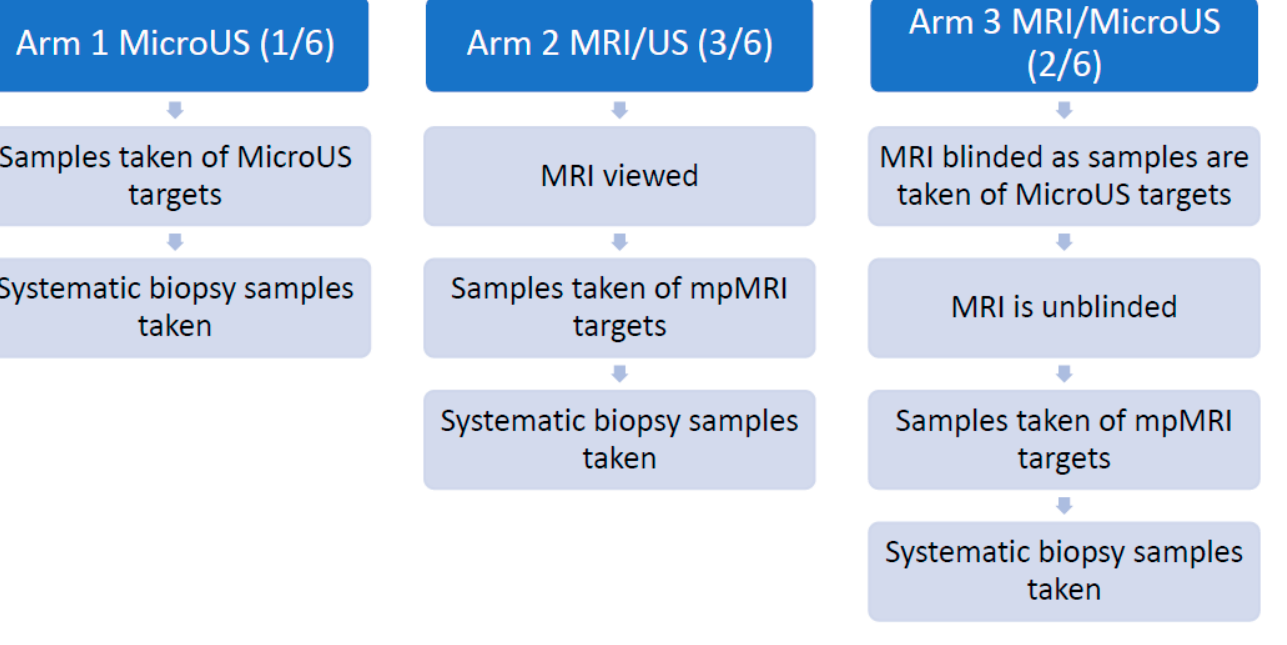
Figure 4. Visual representation of the OPTIMUM study workflow.